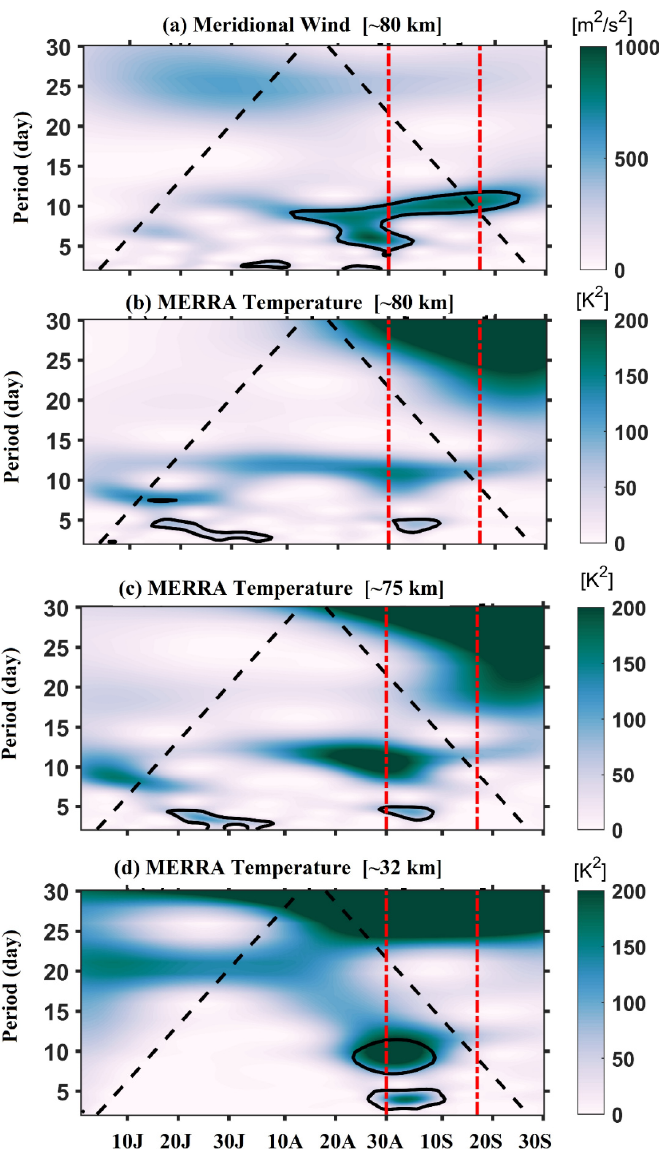
Figure 4. ( a ) Continuous wavelet spectrum of the KSS MR measured meridional winds at 80 km between 1 July and 30 September 2019, ( b – d ) same as ( a ), but for the temperature using MERRA data over KSSMR (62.22 ◦ S, 58.78 ◦ W), at 80 km, 75 km, and 32 km, respectively. The dashed black line in the wavelet spectrum shows the cone of influence. The vertical dashed lines indicate the onset and peak SSW days. The thick black contours indicate the significant periods of the planetary